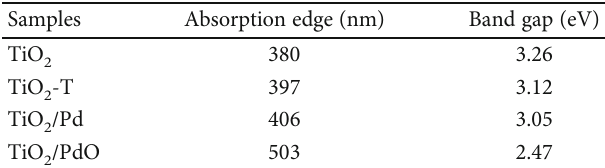
Figure 4: (a) N Table 1: Microstructure of TiO Samples